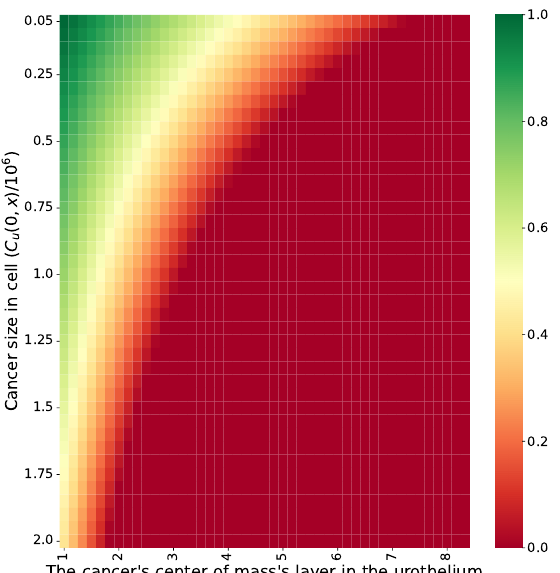
Figure 4. The portion of treatments that resulted in a tumor-free equilibrium for n = 1000 reparations as a function of the initial uninfected cancer cell population size and the layer in which the cancer cell population’s center of mass was located. The results are shown for the standard treatment protocol shown in Table